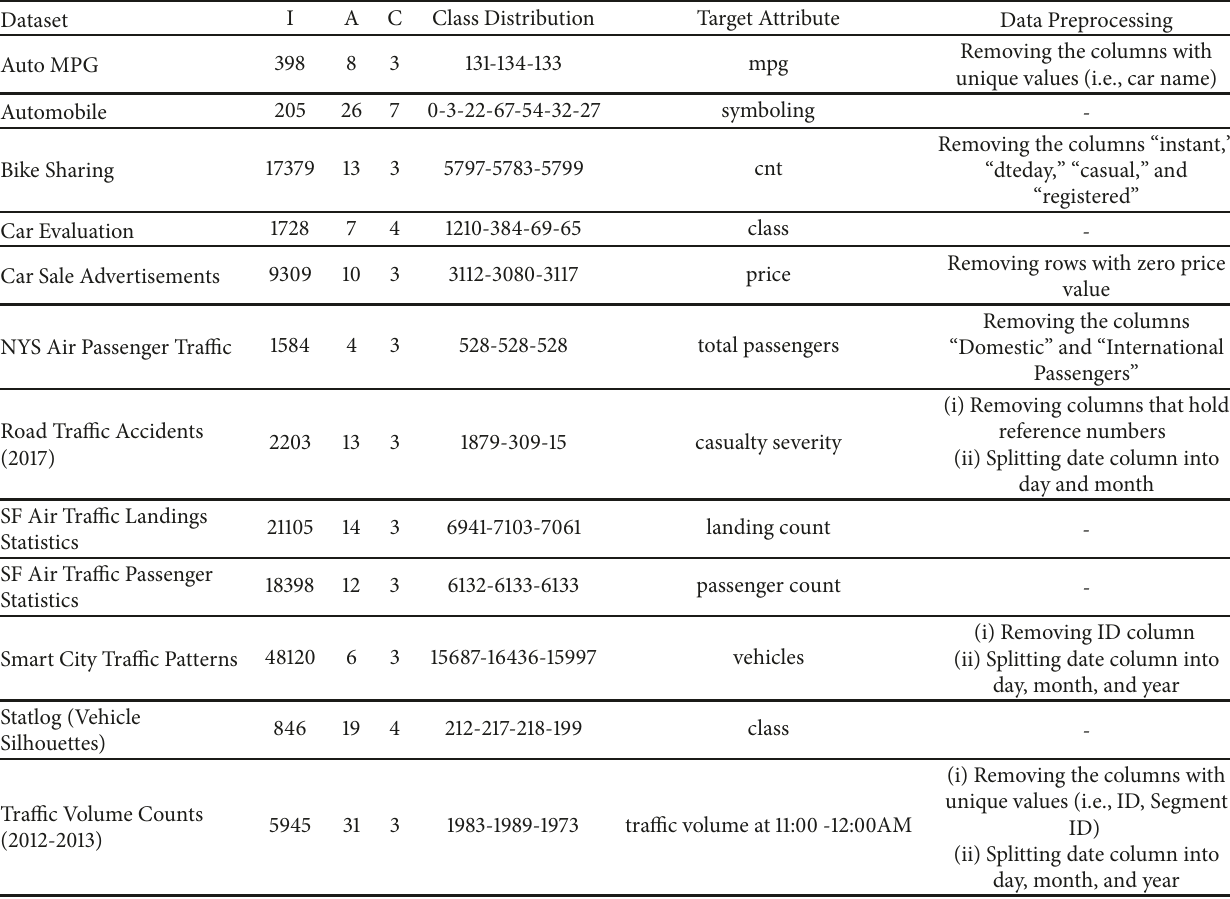
Table 1: The basic characteristics of the transportation datasets. (I: number of instances, A: number of attributes, C: number of classes).